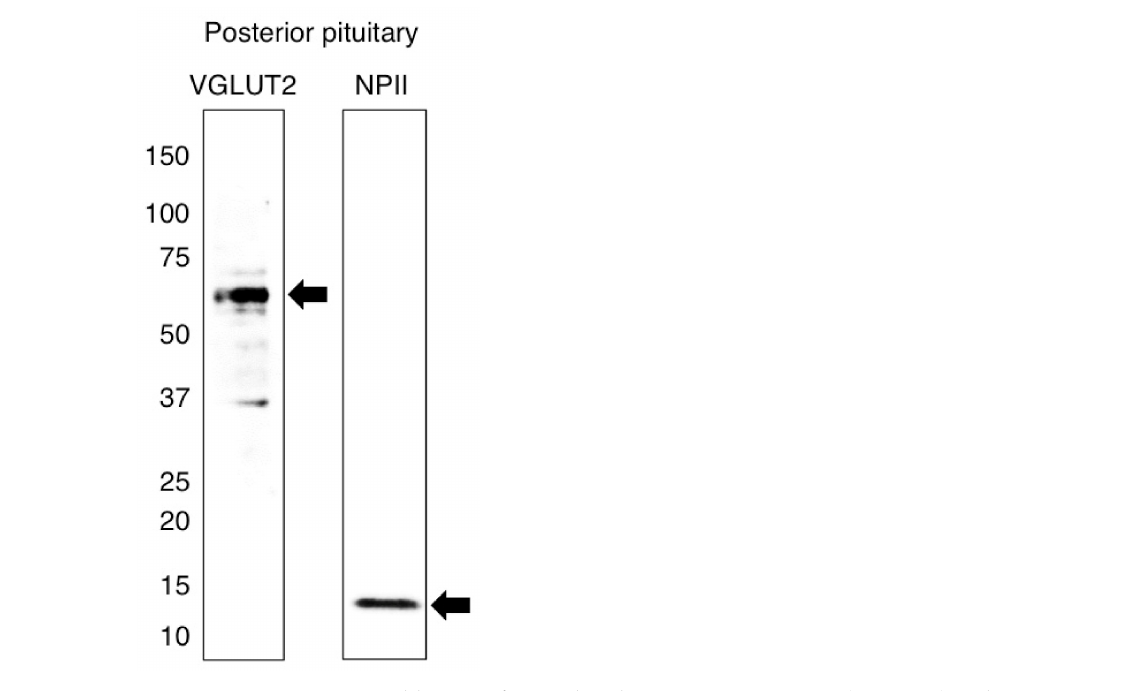
Figure 1. Western immunoblotting of vesicular glutamate transporter 2 (VGLUT2) and vasopressin- associated neurophysin (NPII). The number on the left indicates the molecular weight (kDa). Extracts of protein from the posterior pituitary of the Japanese macaque monkey were transferred onto polyvinylidene difluoride membranes and probed with the guinea pig polyclonal antiserum against VGLUT2 or with the mouse monoclonal antibody against NPII. The antisera recognized a single major band at the expected molecular weight of VGLUT2 (~56 kDa) or NPII (~12 kDa) on a Western blot of the macaque posterior pituitary.